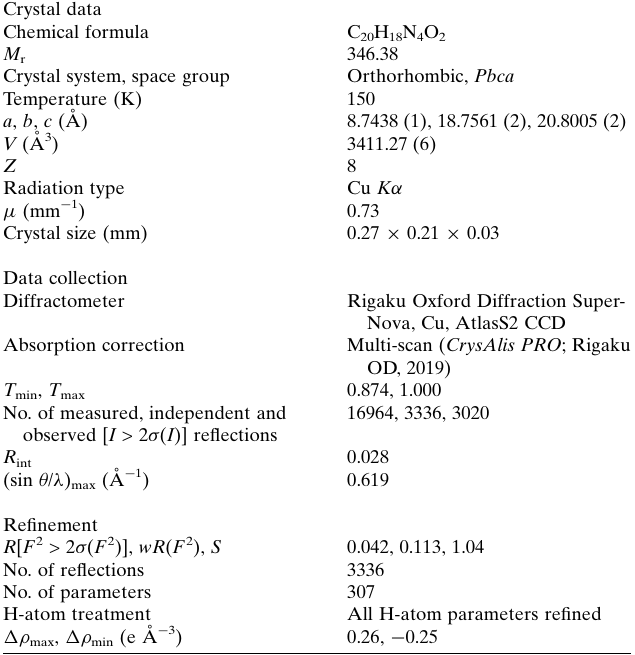
Table 2 Experimental details. Crystal data Chemical